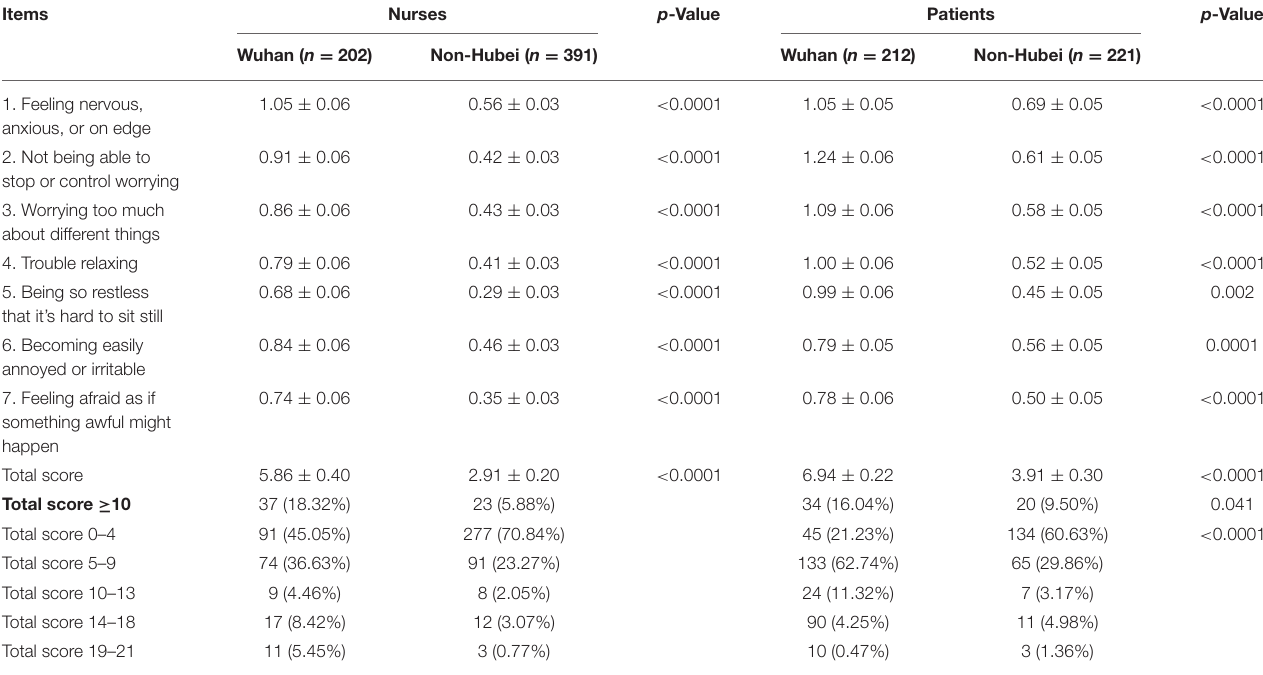
TABLE 4 | Outcomes of GAD-7 for nurses and patients (Mean ± SE).